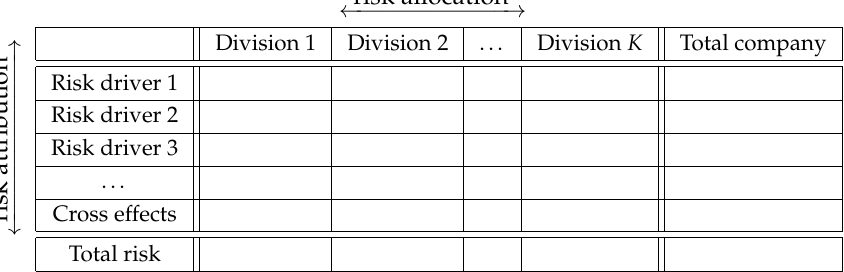
Table 1. Decomposition of risk along two dimensions: risk allocation and